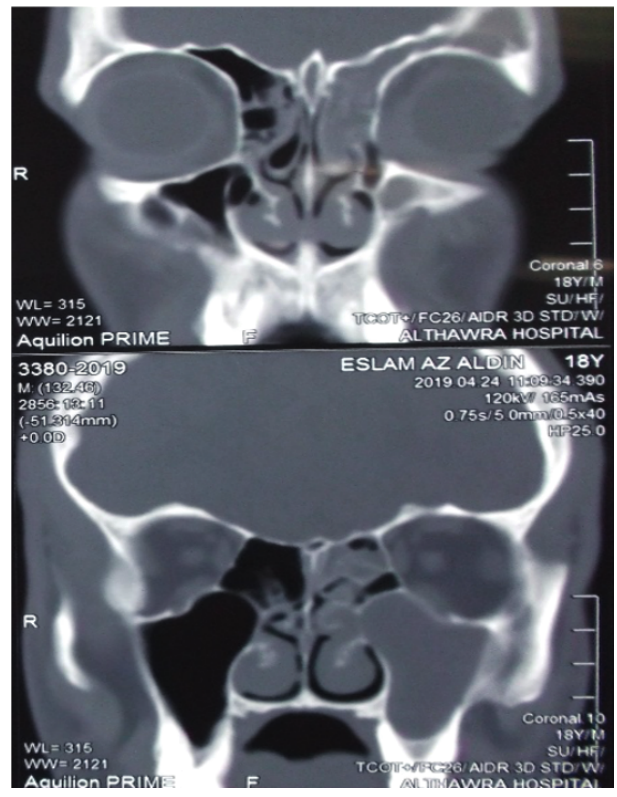
Figure 3. Coronal CT- sections demonstrate the left